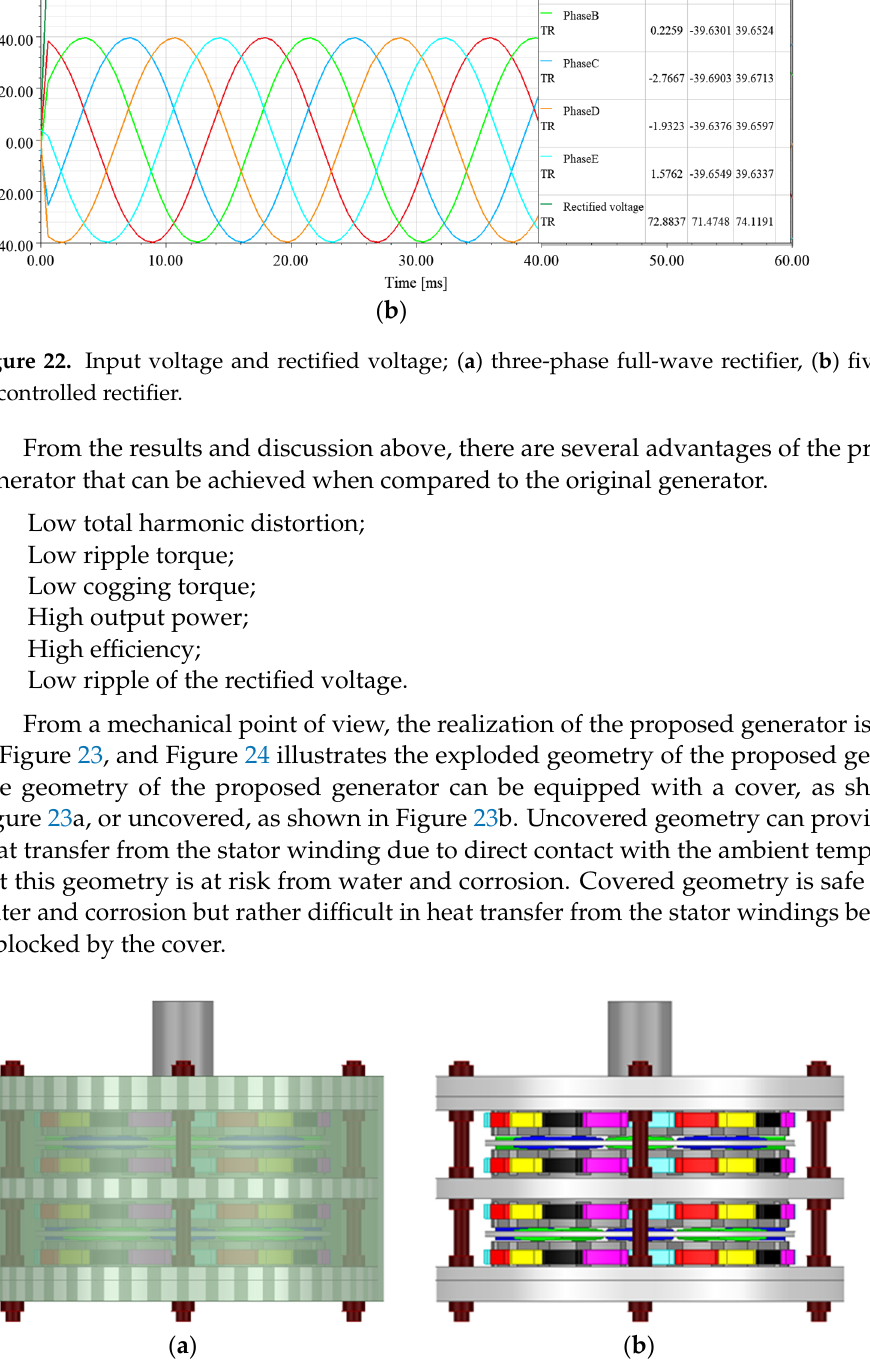
Figure 23. Realization of the proposed generator; ( a ) covered structure, ( b ) uncovered structure.